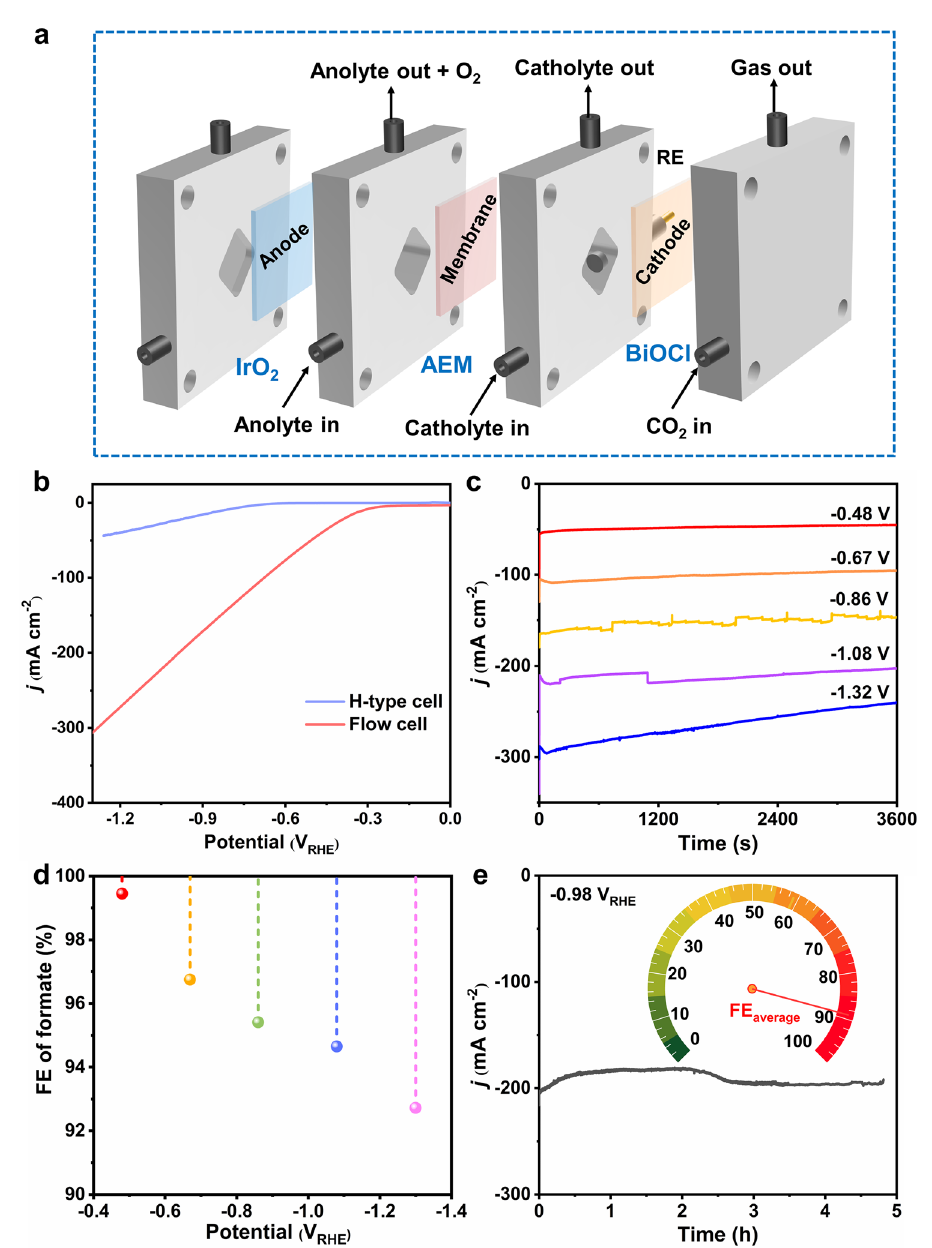
Fig. 3 Electrochemical performance of BiOCl for cathodic CO 2 RR in a flow cell. a Schematic diagram of flow cell. b LSV curves of BiOCl in H-cell and flow cell. c Constant potential electrolysis. d FE of formate in a wide potential window ranging from − 0.48 to − 1.32 V RHE . e Stabil- ity test of BiOCl in flow cell at − 0.98 V